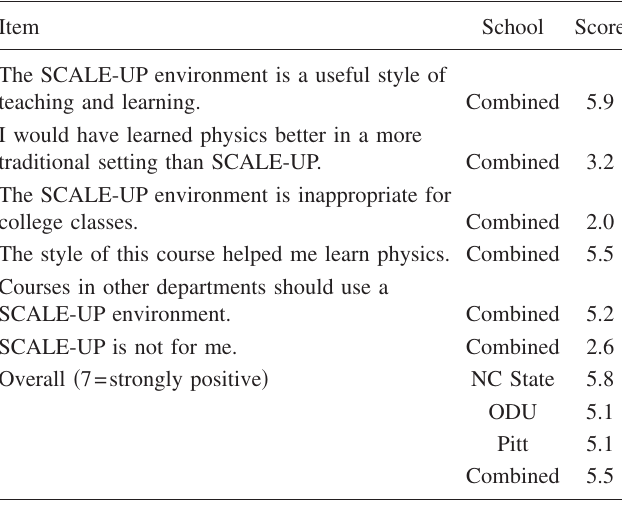
TABLE VI. Affective results. A score of 7 is “strongly agree.”